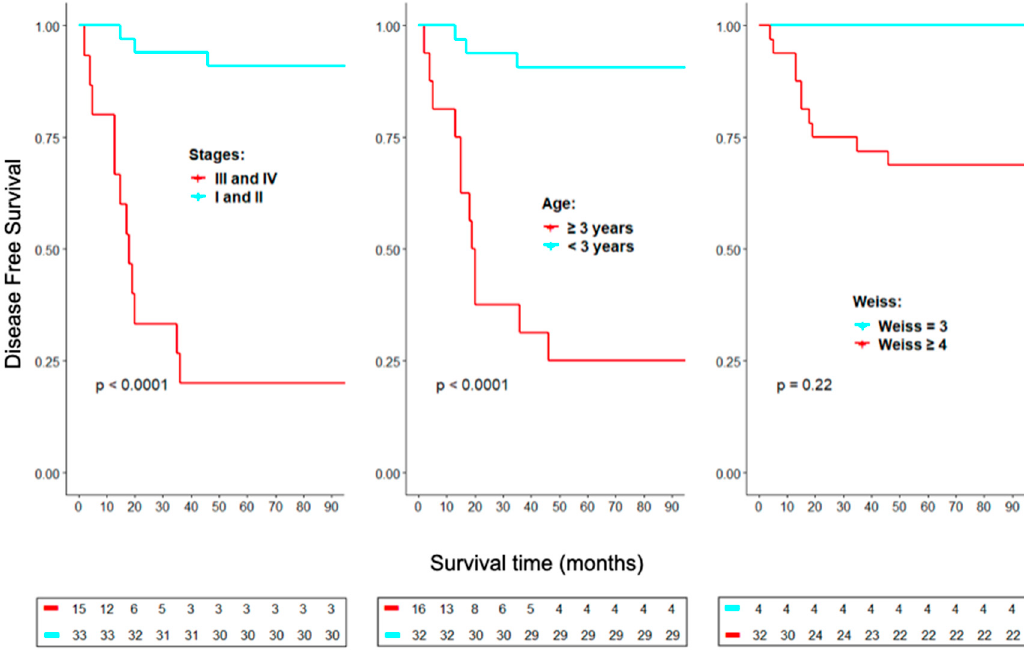
Figure 1. Kaplan-Meier analyses of staging, age at diagnosis, and Weiss score on disease free survival. All death cases were related to the disease. Surviving patients had more than 3 years without recurrence.